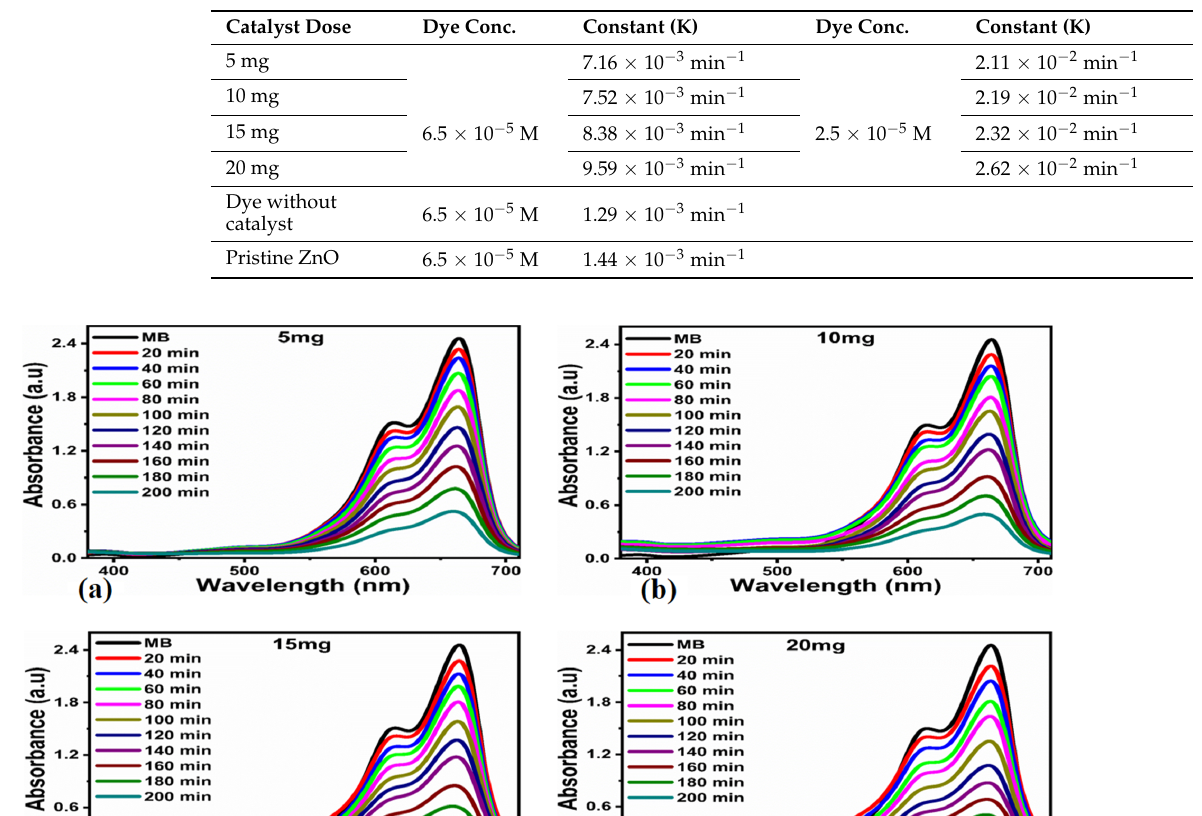
Figure 10. Degradation kinetics for psyllium–ZnO towards removal of MB: ( a ) Ct/Co vs. time, ( b ) ln (Co/Ct) vs. time, and ( c ) dye removal % age vs. time at high concentration. 3.3. Effect of Scavengers For understanding the degradation mechanism, we performed a scavenger study us- ing ascorbic acid (C 6 H 6 O 8 ), sodium borohydride (NaBH 4 ), and ethylenediamine tetraace- tate (EDTA), as shown in Figure 11. They significantly affect the concentration of (O − 2 ), and hydroxyl radicals ( • OH) [34]. It is shown that the degradation of MB is effectively controlled by the oxidizing species [33,34]. This is the reason why we investigated the